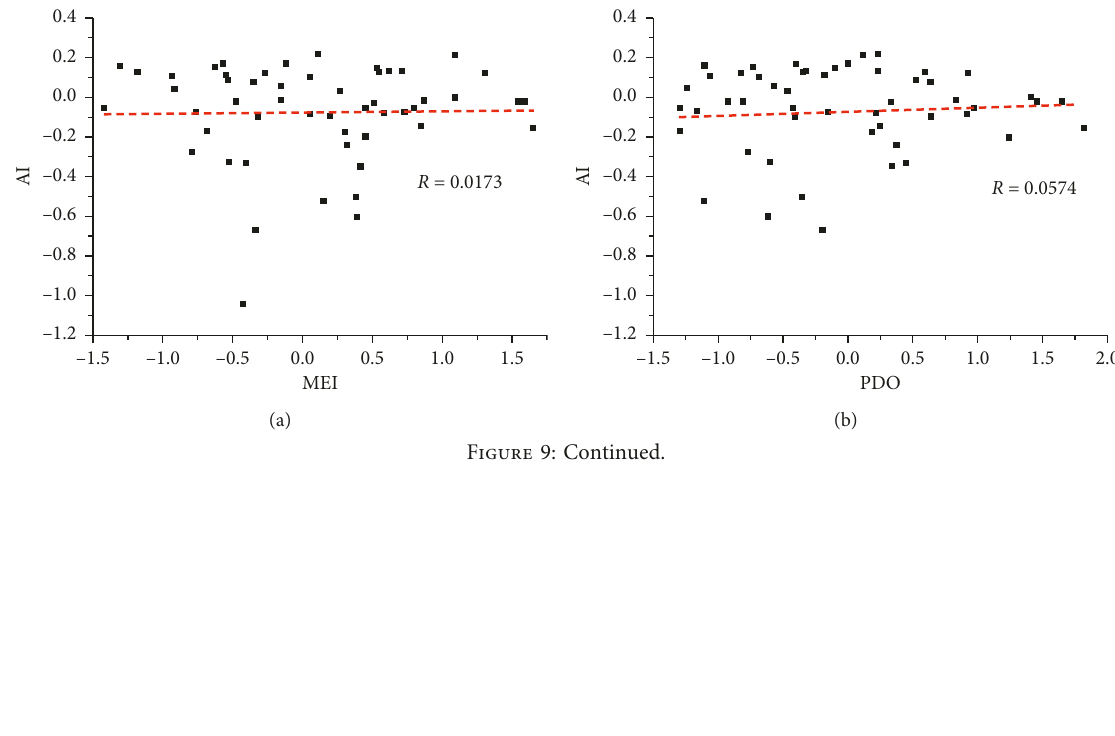
Figure 8: Morlet wavelet transformation of annual AI from 1965 to 2017 over Northeast China. (a) The annual ET wavelet analysis. (b) The local wavelet power spectrum of (a). The thick black contour designates the 5% significance level against red noise and the cone of influence (COI) where edge effects might distort the picture is shown under a thin black curve. (c) Fourier power spectrum of annual ET 0 (solid). The dashed line is the 95% confidence spectrum. (d) Scale-averaged wavelet power over the 2–8 yr band for annual ET 0 (solid). The dashed line is 95% confidence level (the method is cited from [35,